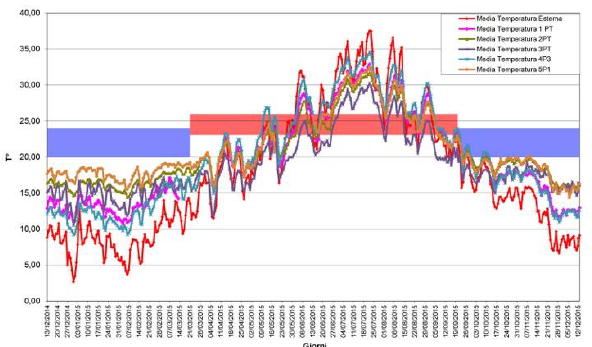
Figure 5. Temperature graph. Monitoring period from 13th